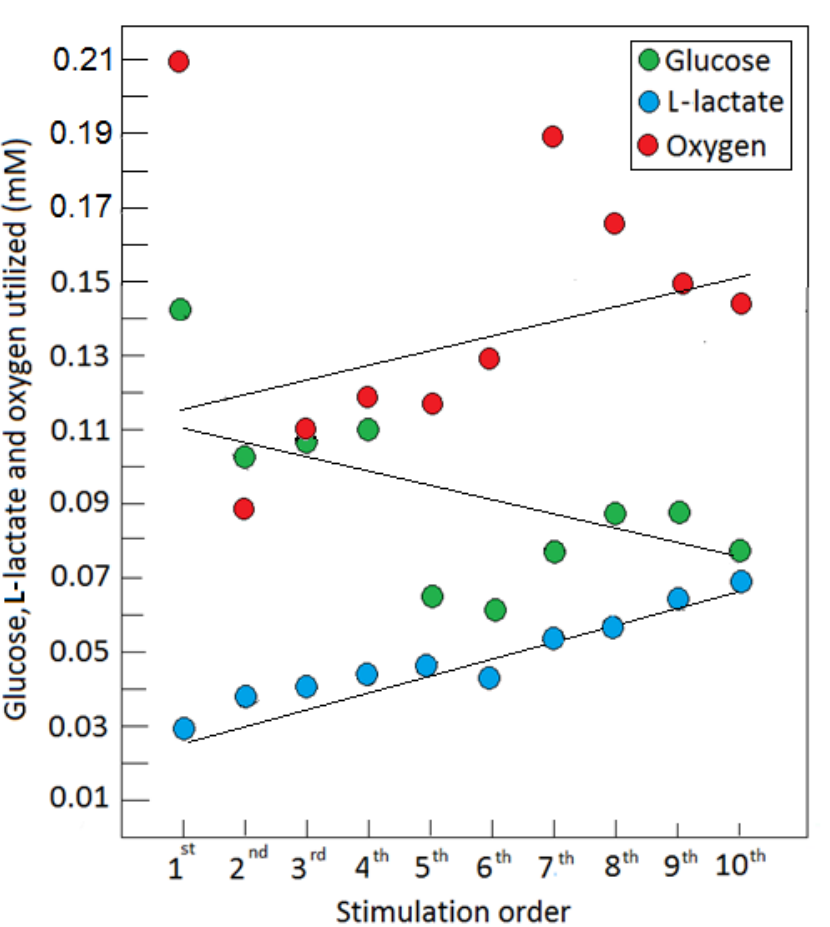
Figure 2. The amount, in mM, of each of the three substrates of cerebral energy metabolism, glucose, L-lactate, and oxygen, consumed in a rat hippocampal dentate gyrus during a series of 5 s electrical stimulations of the perforant pathway at 2 min rest intervals. The amounts were calculated from the depth of each dip in the level of each substrate immediately following each stimulation [21] (see Figure 1). With every consecutive stimulation, beginning with the second one, the amount of glucose consumed decreased, while that of L-lactate increased. Oxygen consumption remained more or less constant.